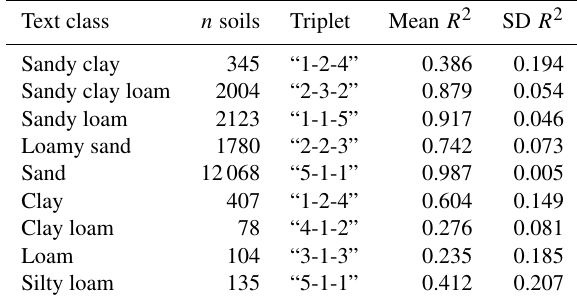
Table 3. Summary of triplets for ln K sat with highest R 2 mean val- ues for regressions using 10 interval binnings. Both the mean value and the standard deviation of R 2 are